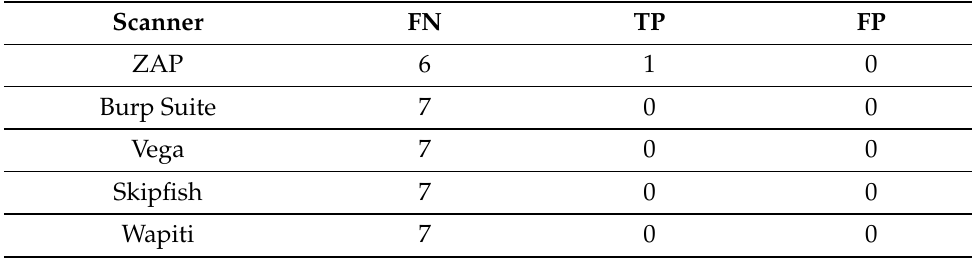
Table 4. FN, TP, and FP results in mode 1.